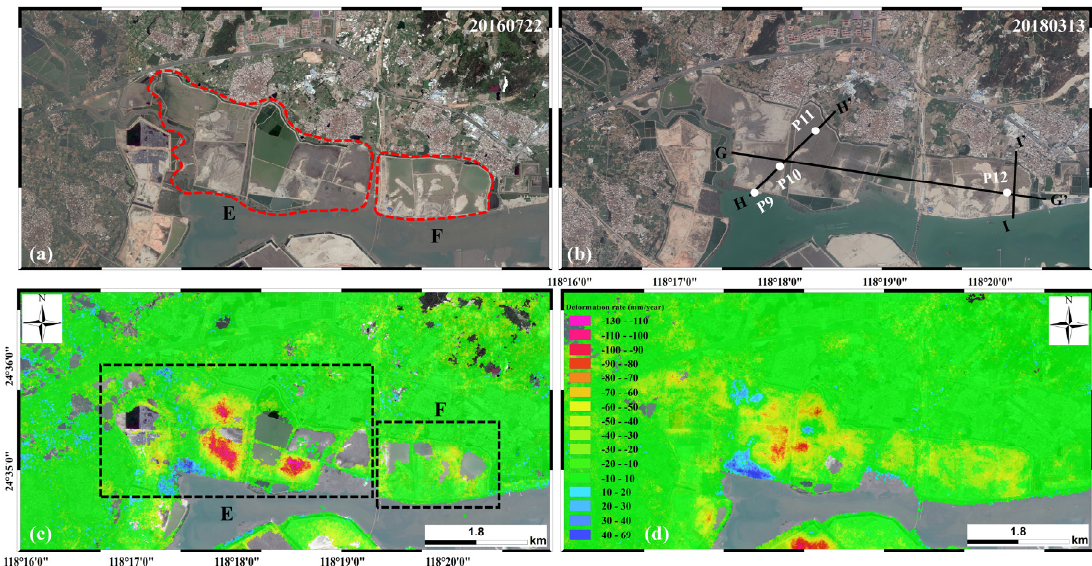
Figure 9. Ground deformation rate maps and remote sensing images of Regions E and F. ( a ) Remote sensing image acquired on 22 July 2016; ( b ) remote sensing image acquired on 13 March 2018; ( c ) average ground deformation rate map from November 2015 to December 2016; ( d ) average ground deformation rate map from January 2017 to October 2018.